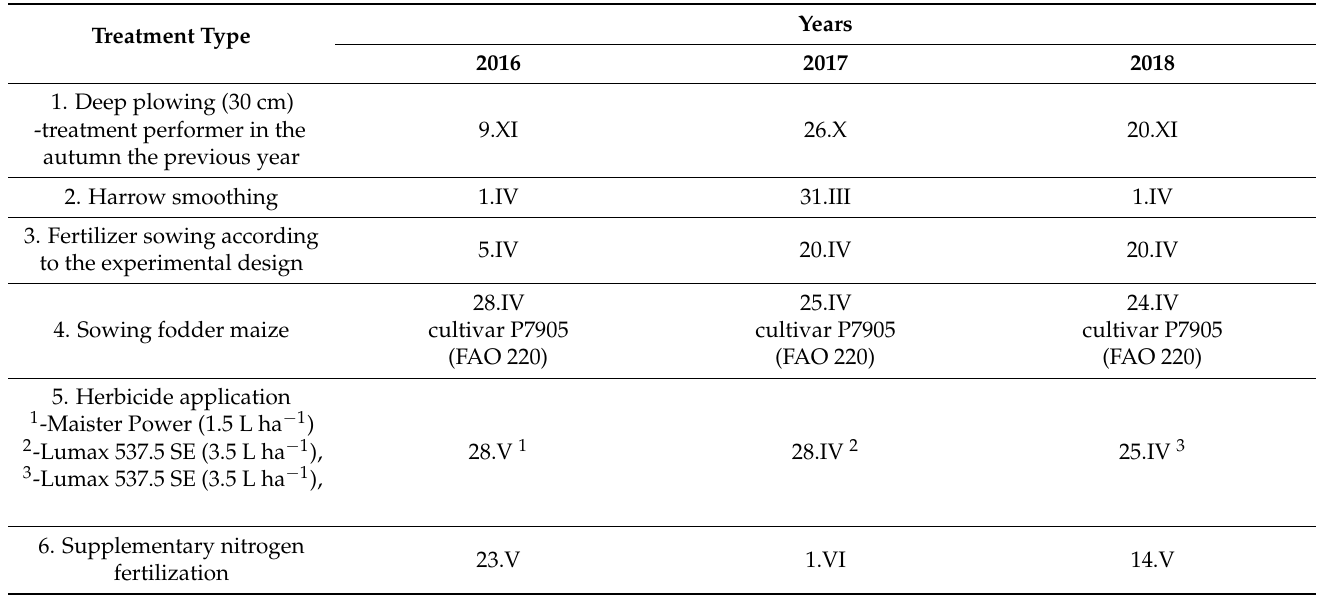
Figure 1. View of the maize experimental field in 2017. Photo taken from the drone (photo by the Szulc). Table 1. Time points (dates) of agrotechnical treatments from